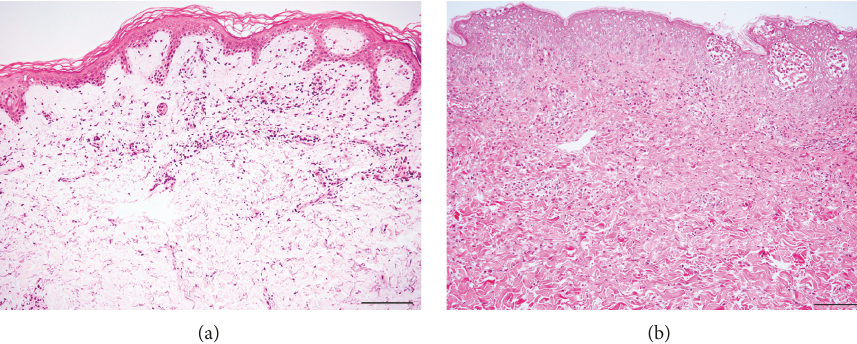
Figure 2: HE sections of drug-induced hypersensitivity syndrome/exanthema in drug reaction with eosinophilia and systemic syndrome. Two cases that are associated with liver function de fi ciency show di ff erent histopathologies: intermittent interface change, few necrotic keratinocytes, and slight spongiosis in (a); di ff use interface change, several necrotic keratinocytes, and considerable spongiosis with spongiotic bullae in (b). Bar=100 μ m.